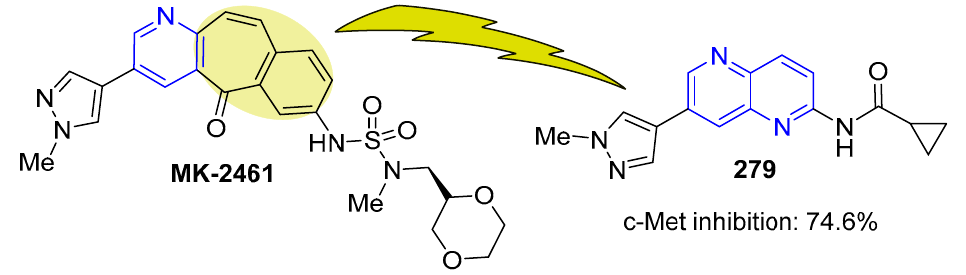
Figure 10. Inhibition of c-Met kinase activity.